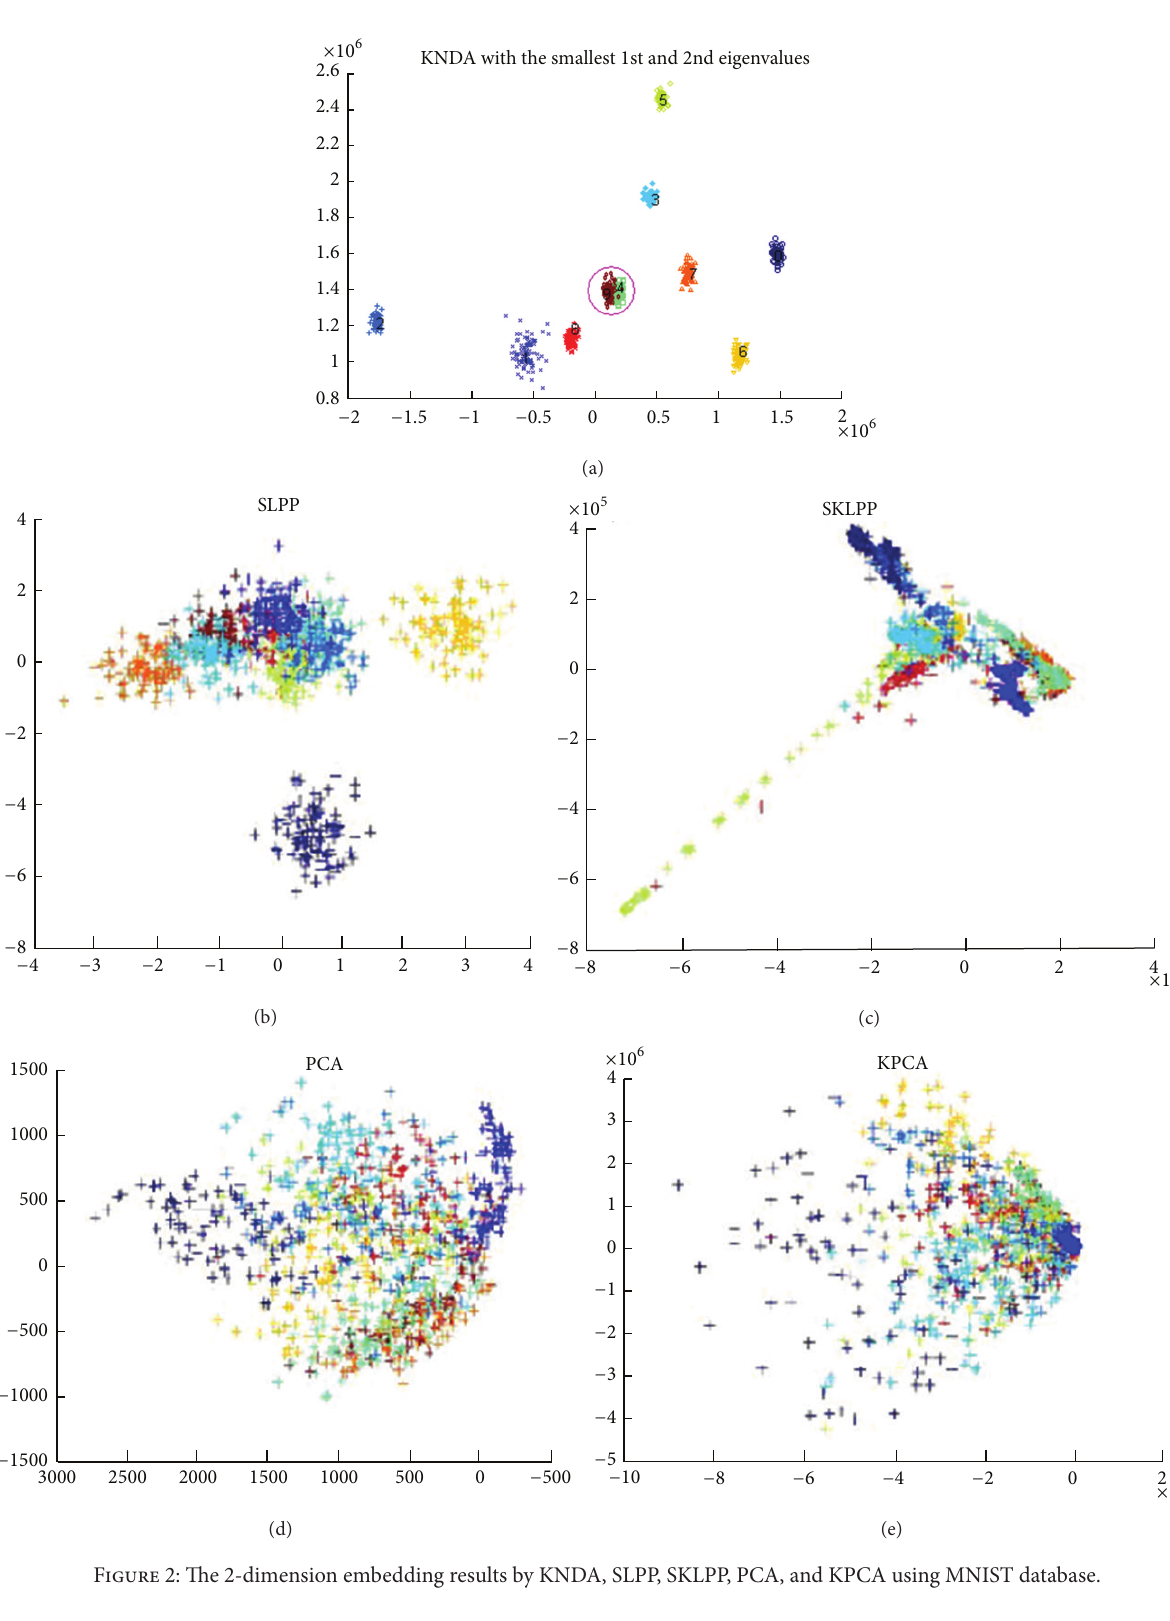
Figure 2: The 2-dimension embedding results by KNDA, SLPP, SKLPP, PCA, and KPCA using MNIST